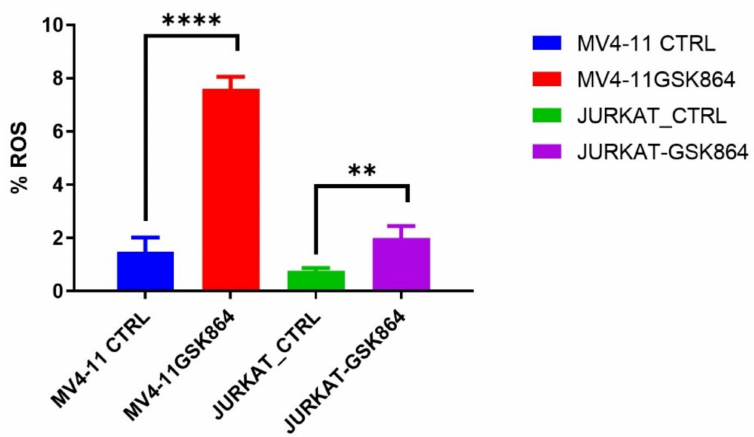
Figure 7. IDHi induces ROS in leukemic cells. Quantitative levels of ROS in control and treated leukemic cells; ** p < 0.00, **** p < 0.0000. Wild-type IDH1 is a potential therapeutic target; we treated leukemic cells with GSK864. Cytoxan Red was used to differentiate live cells from apoptotic cells. We observed that IDHi induced 17% of apoptosis in MV411 and Jurkat cells. IDHi prevented cell proliferation in leukemic cells (Figure